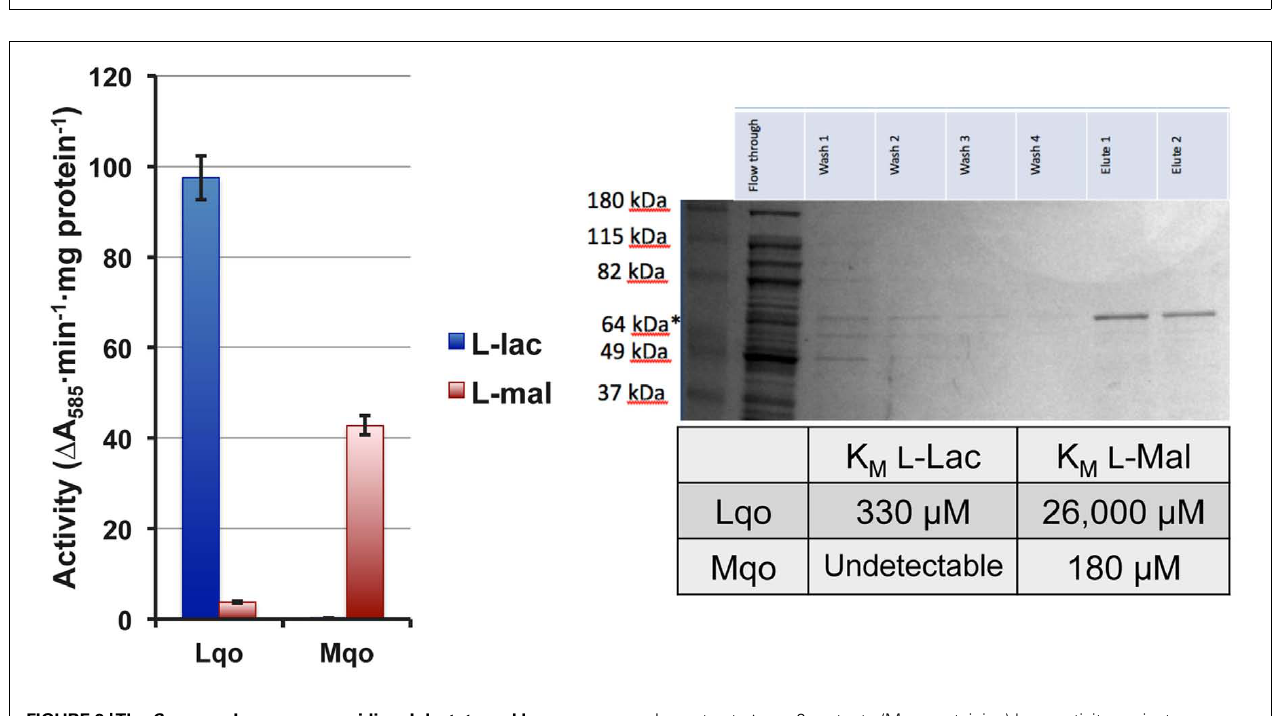
FIGURE 3 |The S. aureus Lqo enzyme oxidizes L-lactate and has no affinity for malate. Left: Membrane preparations from single mutant S. aureus were assayed for Lqo and Mqo activity. Δ mqo 1 (Lqo-containing) membranes react readily with L-lactate but not malate.